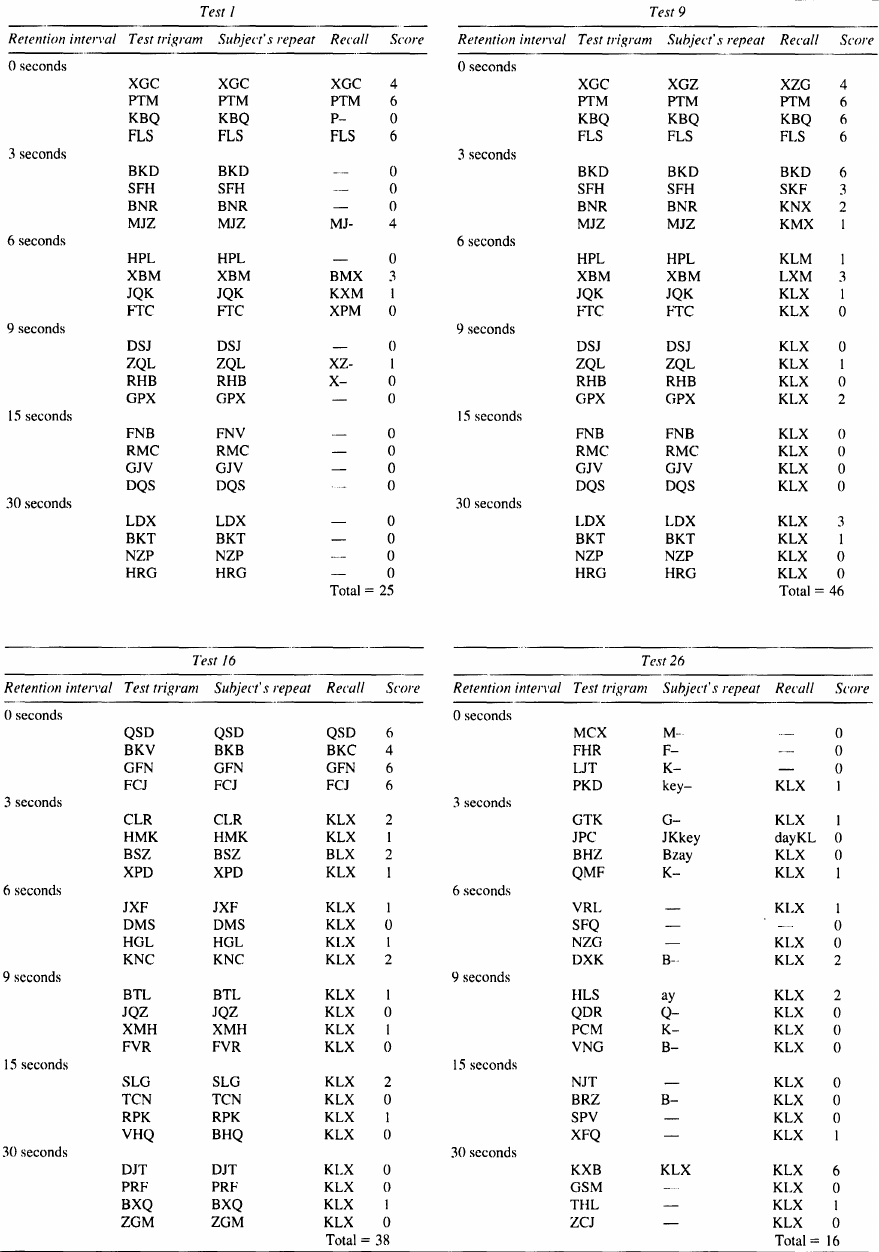
TABLE 1. Examples of the AD patient's responses on the STM distractor test over 4.5 years Test I Test